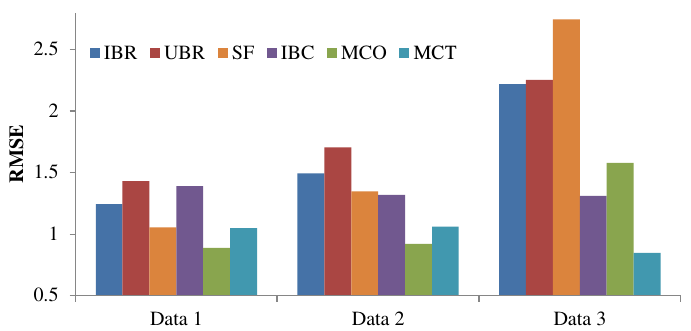
Fig. 5. The comparisons between the proposed methods and compared methods without new users in terms of RMSE.